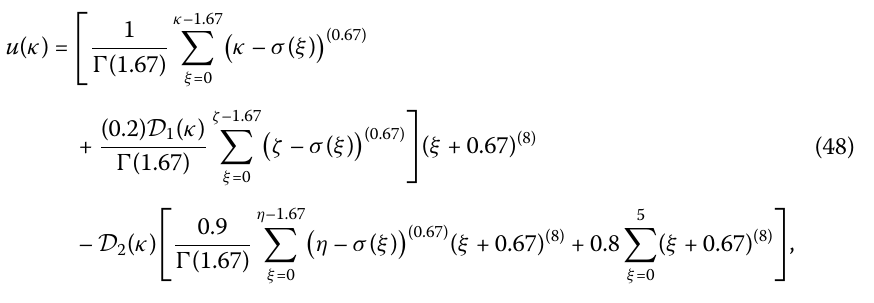
Here, ϑ = 1.67, (cid:8) = 4, δ = 0.8, β = 0.2, γ = 0.9, and F ( κ ) = κ (8) . From Theorem 3.4,